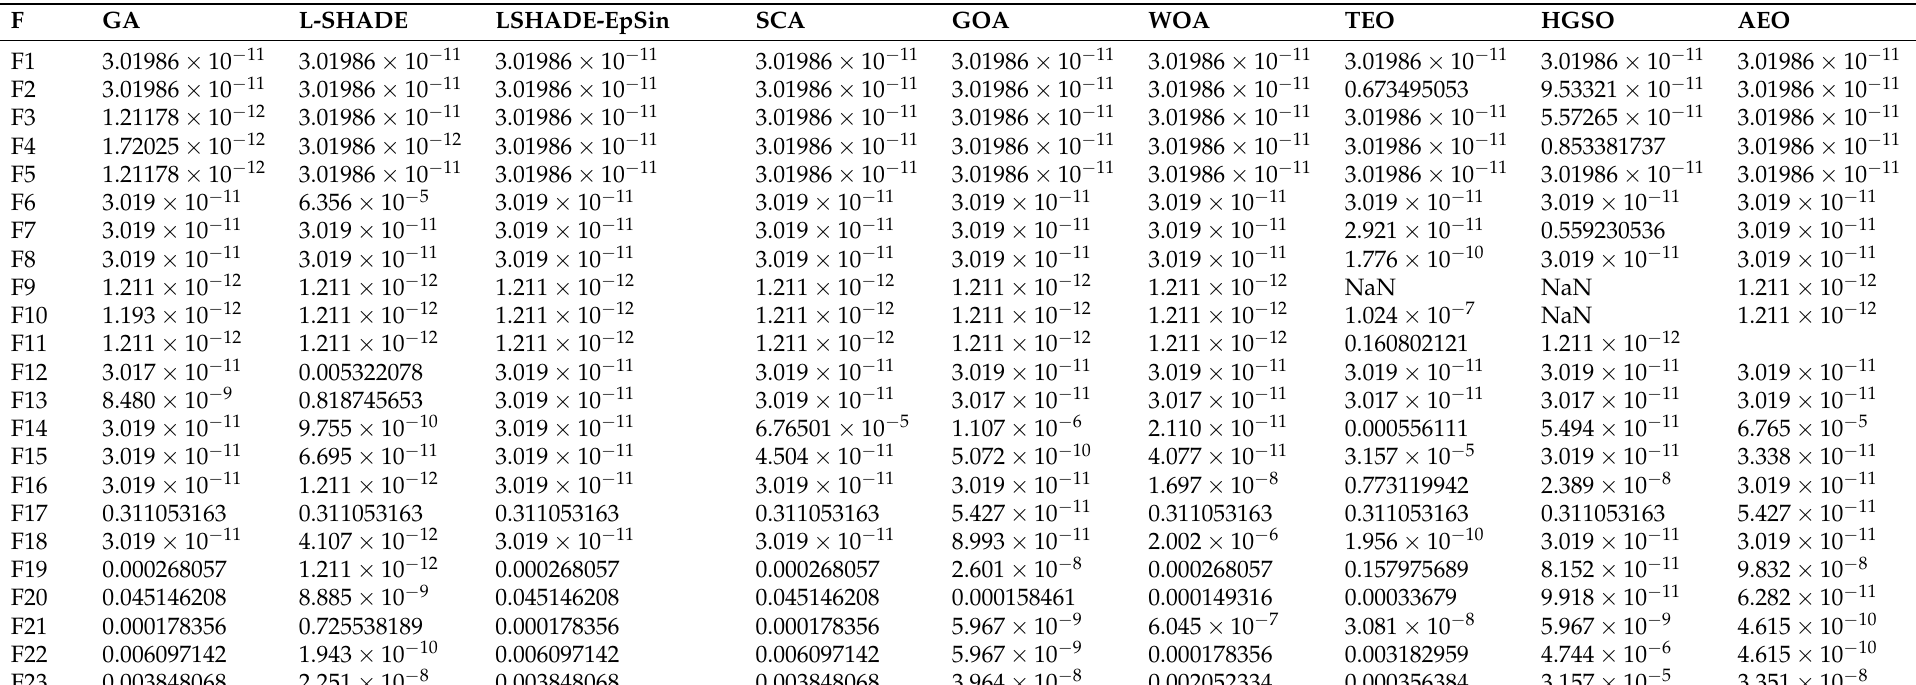
Table 5. Wilcoxon rank sum test results for HHO against other algorithms CEC2020 Dim =